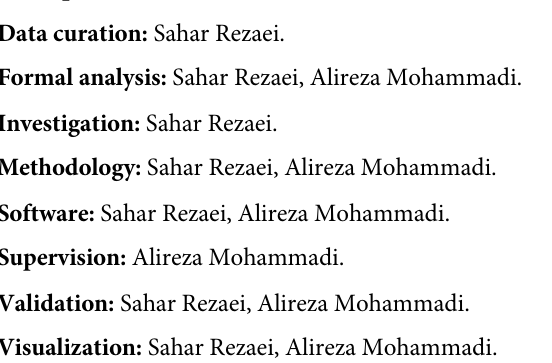
S1 Table. Presence points of golden jackal ( Canis aureus ) and grey wolf ( Canis lupus ) in Markazi province (2000–2019). S2 Table. Environmental and anthropogenic variables and their sources. S3 Table. Variable contribution in the habitat modeling of the grey wolf and golden jackal in central Iran. Republished from [http://www.frw.ir] under a CC BY license, with permission from [Forest, Range, Watershed Management Organization of Markazi province (IFRWO)], original copyright [2021]. Republished from [https://markazi.doe.ir/] under a CC BY license, with permission from [Markazi Province Office of Department of Environment (DOE)], origi- nal copyright